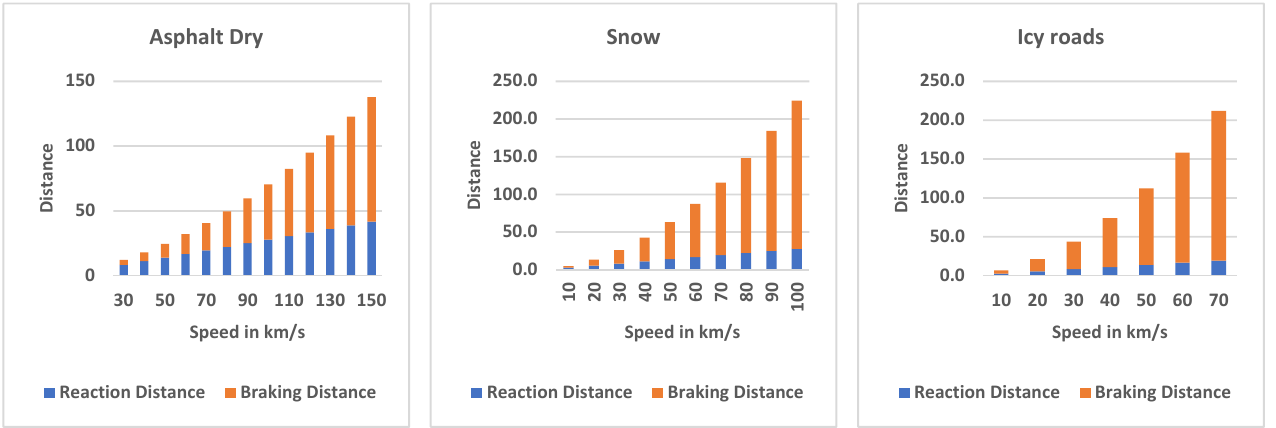
Figure 11. Stopping distance components as the sum of the reaction and braking distances for different speeds and on different road types. The reaction time is considered one second and assumes new normal tires.